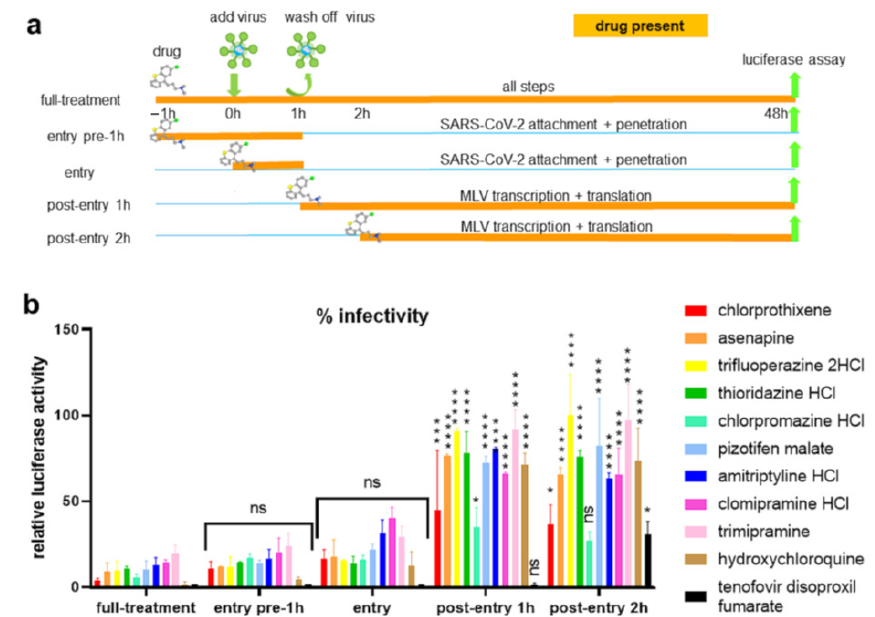
Figure 5. Kite-shaped molecules inhibit SARS-CoV-2 pseudovirus at entry steps. Mouse leukemia virus (MLV) pseudotyped with spike protein (S) from severe acute respiratory syndrome coronavirus-2 (SARS-CoV-2) was used to infect 293T-ACE2 cells in 96-well plates for 48 h in a time-of-addition experiment. ( a ) Schematic of time-of-addition experiment. Full-time treatment involved 1 h drug pre-treatment and 1 h infection in the presence of drug followed by drug and virus wash-off and addition of fresh drug for the rest of 48 h. Entry assay involved 1 h infection in the presence of drug with and without 1 h drug pre-treatment. The drug and virus were washed off and fresh medium was added without drug for the rest of 48 h. Post-entry assay involved no drug pre-treatment and infection in the absence of drug. Following virus wash-off, drug was added at 1 h post-infection (hpi) or 2 hpi for the rest of 48 h. The thick yellow bar indicates the stages when drug is present. Addition of drug is represented by a drug image obtained from PubChem. ( b ) Infectivity was measured as luciferase activity and expressed as % infectivity to infected, own solvent control (dimethyl sulfoxide, ethanol, or water) at the same time point. Data are presented as mean ± SD of two repeats. Statistically significant differences compared with full-time treatment are represented by * p < 0.05, *** p < 0.001 and **** p < 0.0001. ns =